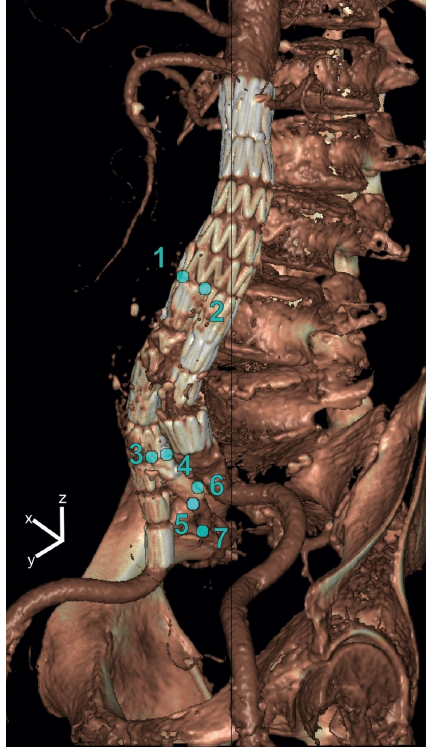
Figure 1. Selected points on the iliac branched device for displacement analysis in x-(lateral), y- (anterior–posterior) and z-(craniocaudal) directions. The points were selected at the bifurcation of the main graft (Points 1 and 2), the IBD flow divider (Points 3 and 4), the distal markers of the IIA component (Points 5 and 6) and the first bifurcation of the IIA (Point 7).